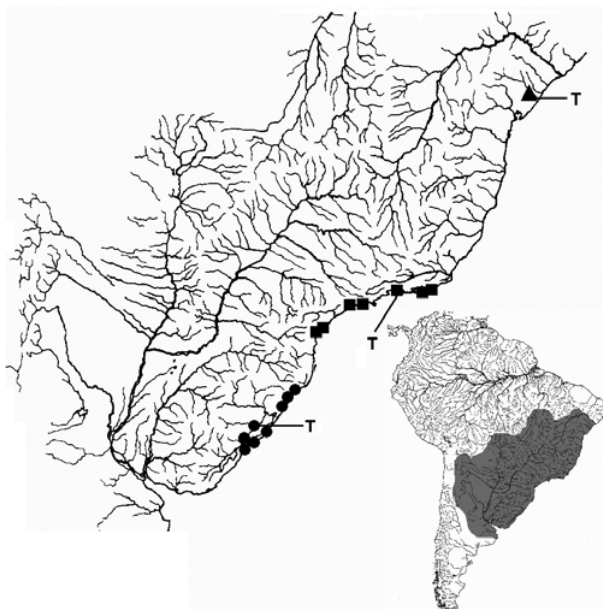
Fig. 1. Coastal drainages from Bahia to Rio Grande do Sul, and Uruguay showing distribution of Phalloptychus eigenmanni (triangle), P . januarius (squares), and P . iheringii (circles). Each symbol may represent more than one lot and/ or locality. T = type